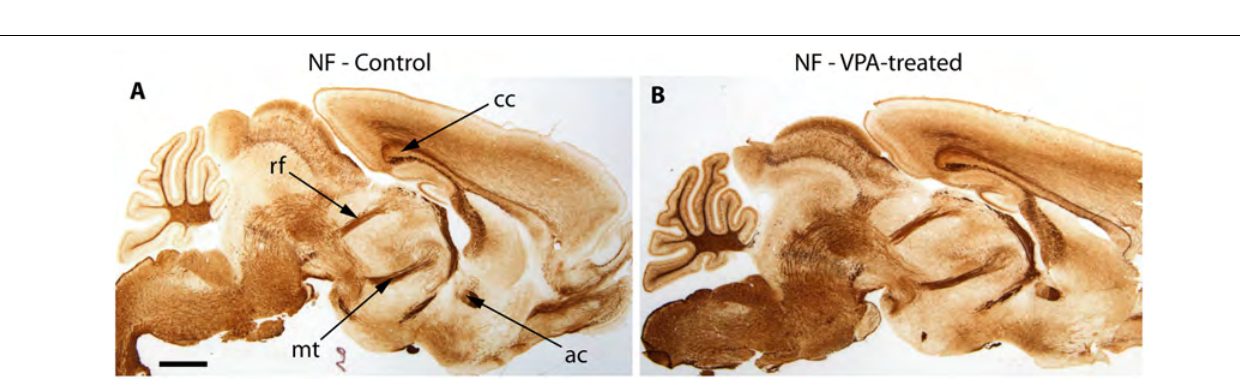
FIGURE 7 | Representative matching pair of paraffin-embedded sagittal sections from control (A) and VPA exposed (B) P7 mice immunostained for neurofilament protein (NF). No difference in the morphology of major brain tracts is evident. ac, anterior commissure; cc, corpus callosum; rf, retroflex fascicle; mt, mamillothalamic fascicle. Scale bar: 1